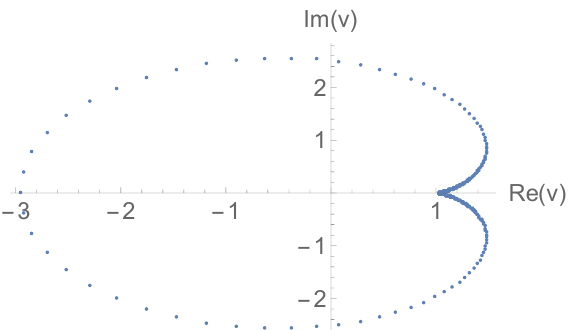
Figure 1 . Plot of v with d = 10 ; (cid:14) 1 = 0 : 6 ; (cid:14) 3 = 0 : 4 ; (cid:14) 2 = 0 : 2 ; (cid:14) 4 = 0. The horizontal axis is Re[ v ], and the vertical axis is Im[ v ]. We plot v from t = 8 to t =